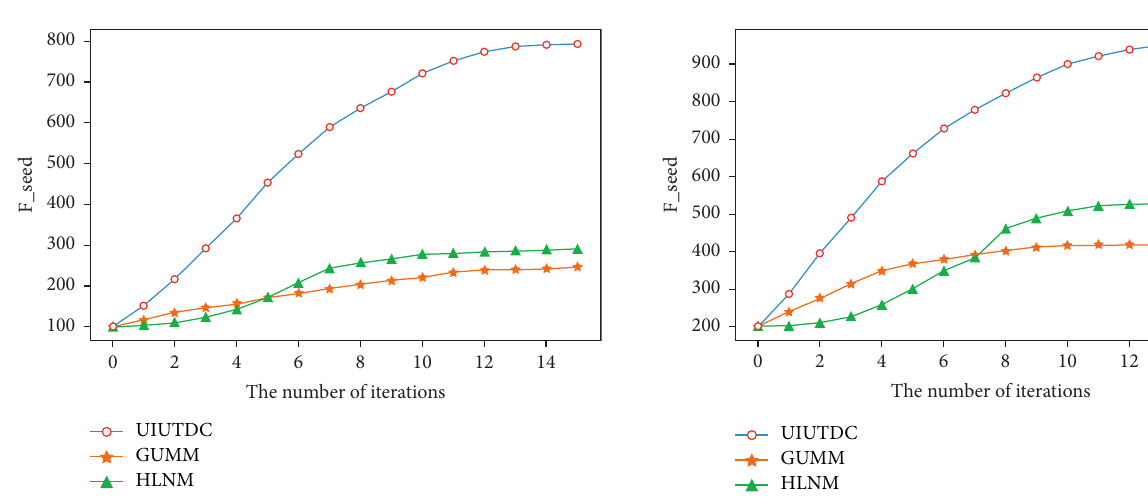
Figure 7: Comparison diagram of 200 prior seed nodes to